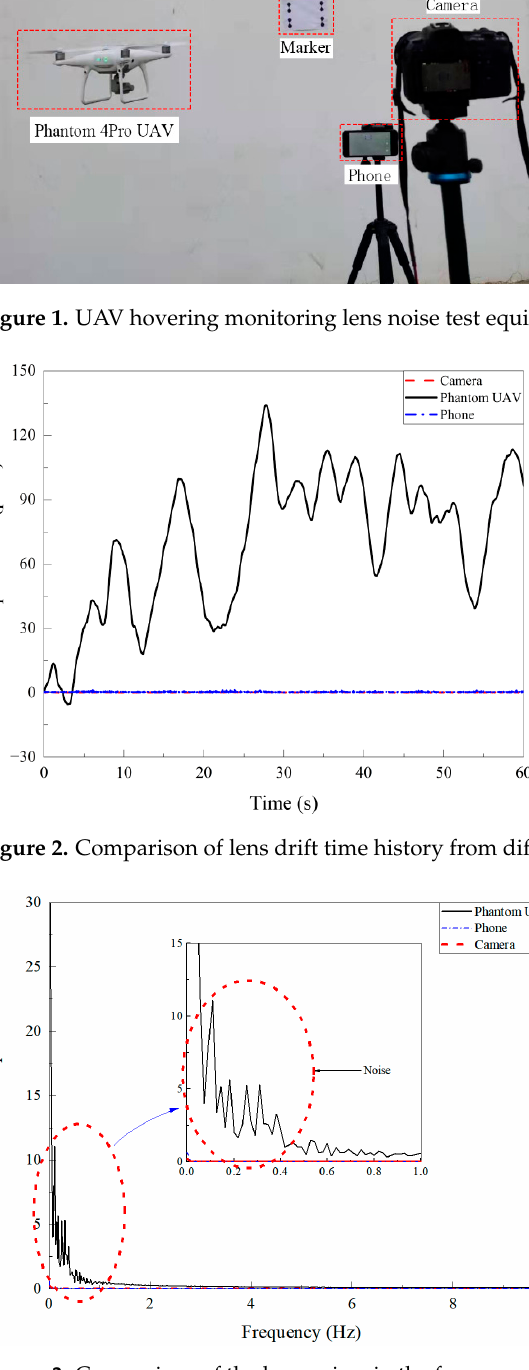
Figure 3. Comparison of the lens noises in the frequency domain obtained from different equipment.